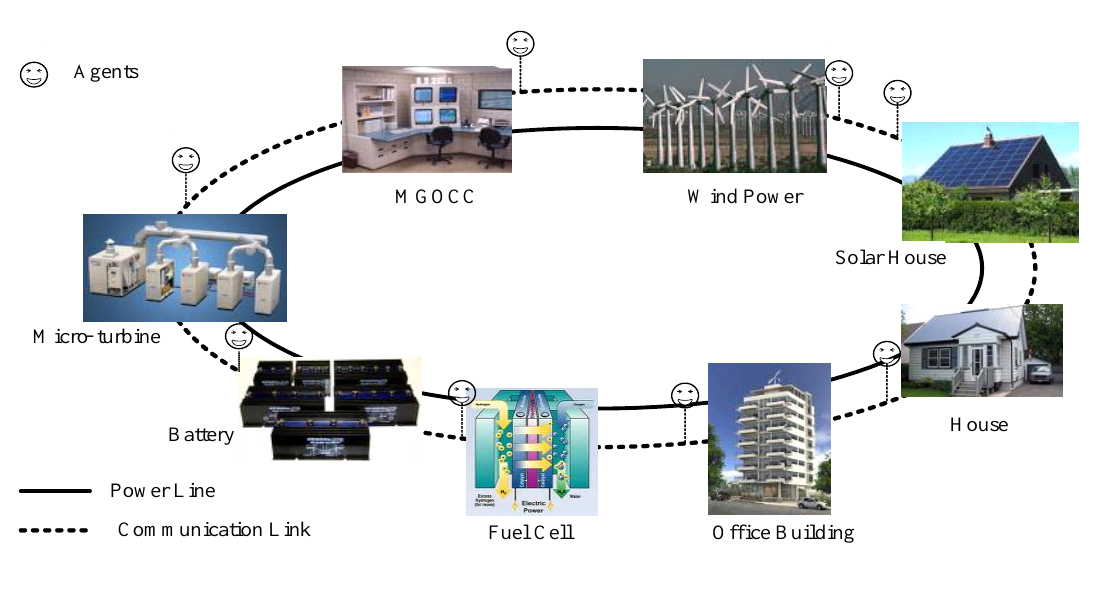
Figure 4. Multiagent-based islanded microgrid.